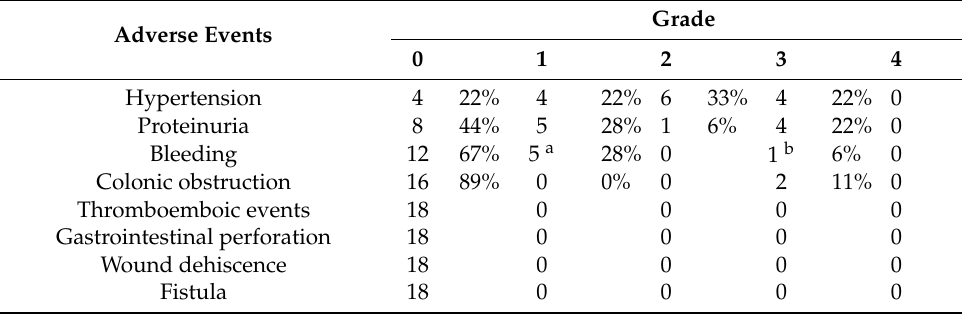
Table 2. Adverse events induced by bevacizumab in bevacizumab+ group ( n =